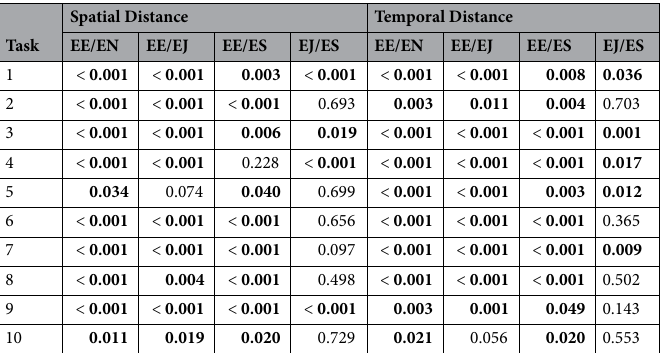
Table 2. p -value for Mann–Whitney test on all group comparisons with overall spatial distance and Kullback– Leibler temporal distance. Bold numbers highlight a p -value smaller than 0.05.